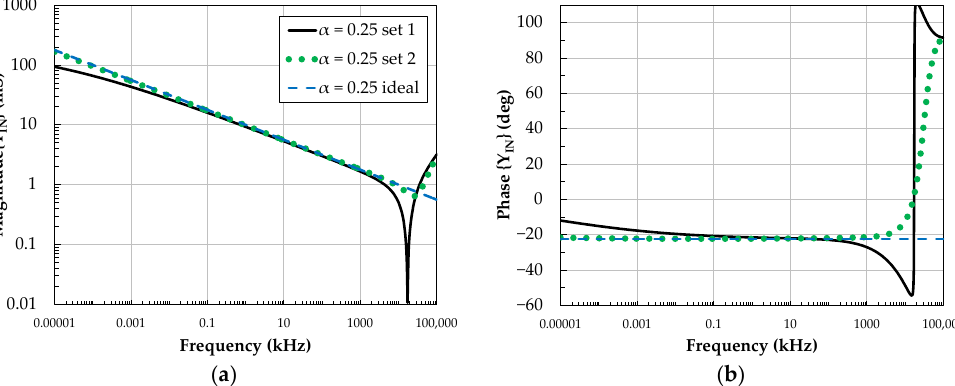
Figure 10. Simulated magnitude ( a ) and phase ( b ) characteristics of gyrator input admittance for α = 0.25.